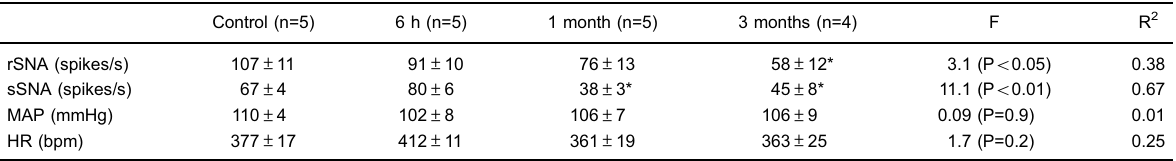
Table 1. Comparison of renal and splanchnic sympathetic nerve activity (rSNA and sSNA, respectively), mean arterial pressure (MAP), and heart rate (HR) values between the control and sepsis groups at different time-points.